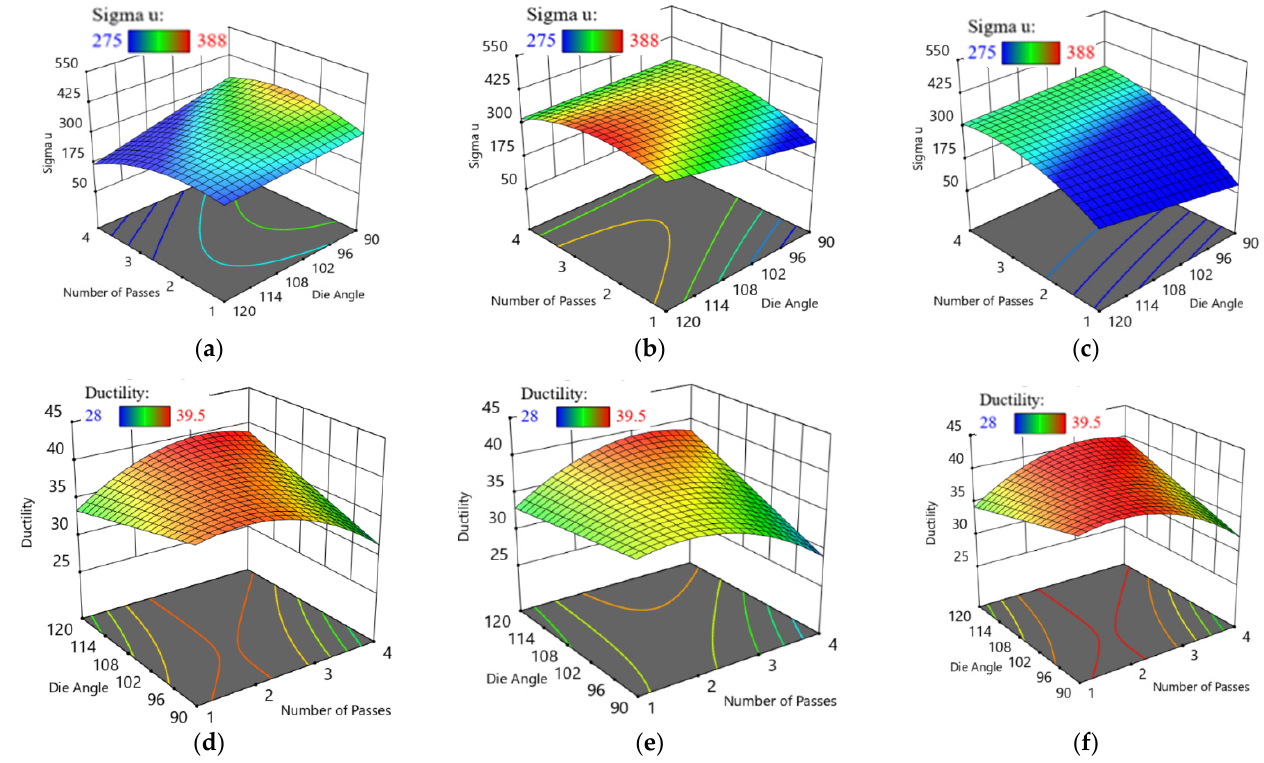
Figure 10. Three-dimensional plot of σ u ( a – c ) and D ( d – f ) with N and ϕ at route A ( a , d ), Bc ( b , e ) and C ( c , f ).